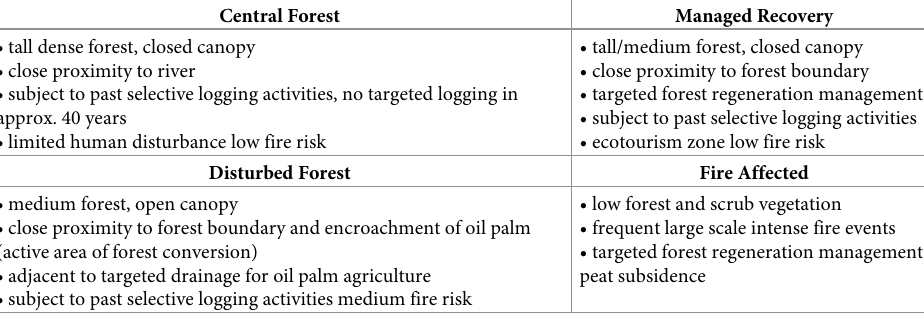
Table 1. Description of forest condition